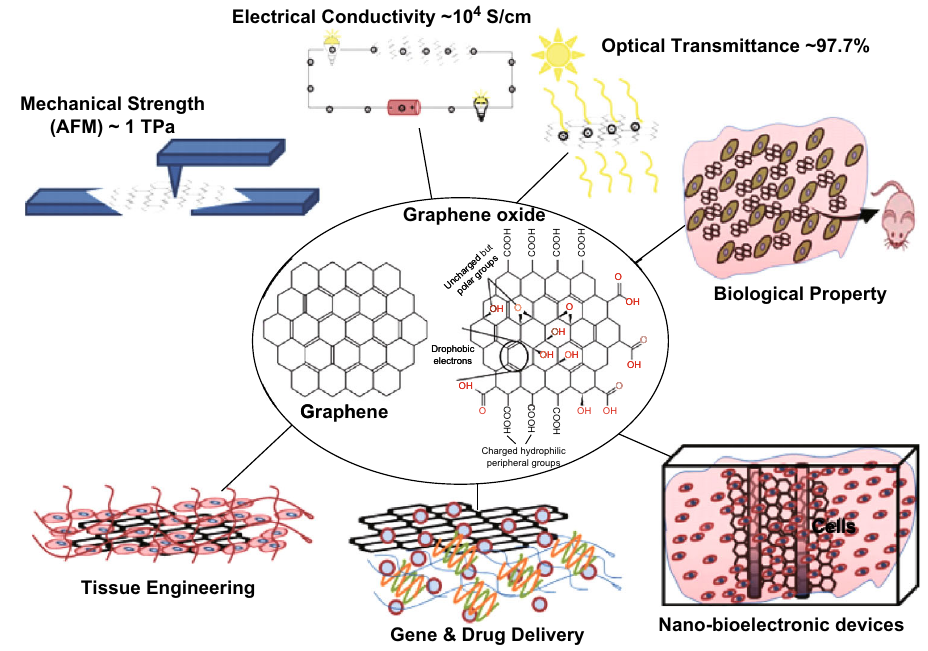
Fig. 5 Schematic overview of medical and non-medical applications of GBNs [118]. Copyright (cid:2) Elsevier